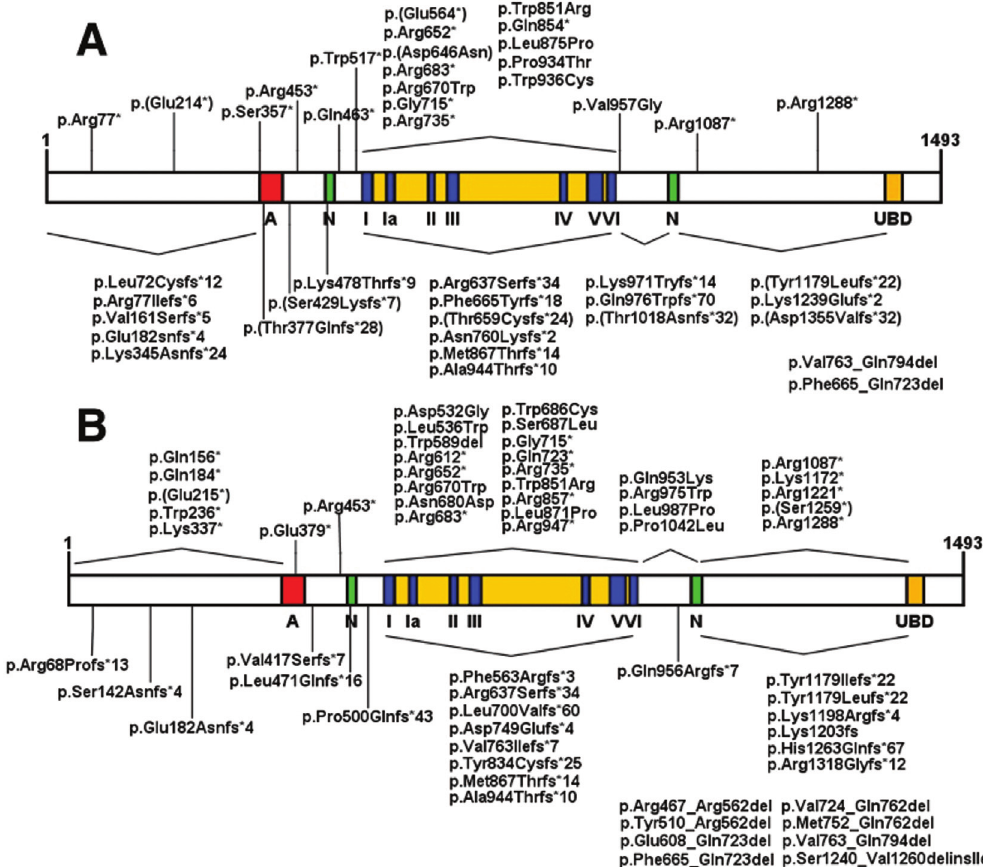
Figure 2 - Representation of CSB protein and domains. Acidic region (A), nuclear localization signal (N), helicase motifs (I, Ia –VI) and ubiquitin bind- ing domain (UBD). (A) Homozygous mutations are indicated: frameshifts and nonsense mutations are indicated above the protein, while deletions and missense mutations are indicated below the protein. (B) Represents heterozygous